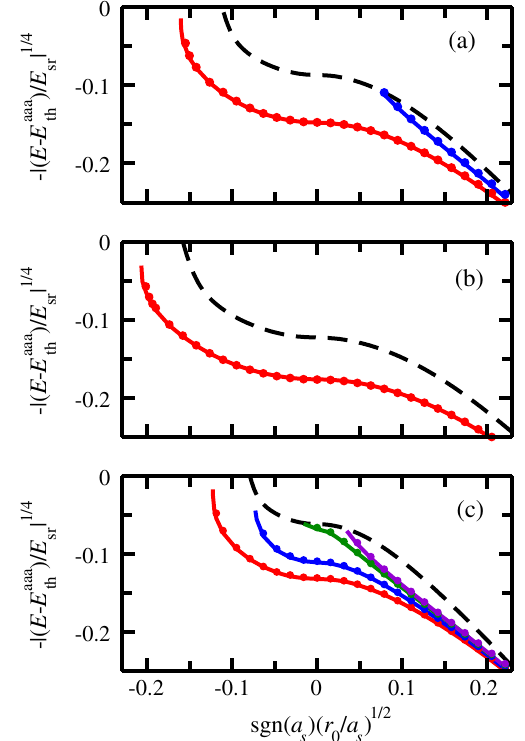
FIG. 2. Testing the generalized radial scaling law in the presence of 1D spin-orbit coupling. Panels (a) – (c) demonstrate the collapse of two neighboring energy manifolds for the finite- ˆ ¯ ¼ V H range interaction model [ in Eq. (20) with V 2 ffiffiffi p 2 b ; G and rel b ¼ V ¼ 8 V 3 r 0 and ð κ (cid:3) Þ − 1 ≈ 66 . 05 r 0 ]. The energies of 3 b ; G ; R 0 b states in the lowest manifold (solid lines) are obtained for ˜ δ ¼ 0 Ω ¼ 2 E Þ − 1 ¼ 50 r ð k Þ − 1 ¼ 25 r , , and (a) ð k 0 , (b) 0 , so so so Þ − 1 ¼ 100 r and (c) ð k 0 . In all three panels, the dashed lines show so the atom-dimer threshold. The dots show the energies of states in the second-lowest manifold, with the generalized radial scaling law applied in reverse so as to collapse the three-body energies of states in the second-lowest manifold (dots) onto the three-body energies of the states in the lowest manifold (solid lines). For clarity, the scaled atom-dimer thresholds for the second-lowest energy manifold are not shown in any of the